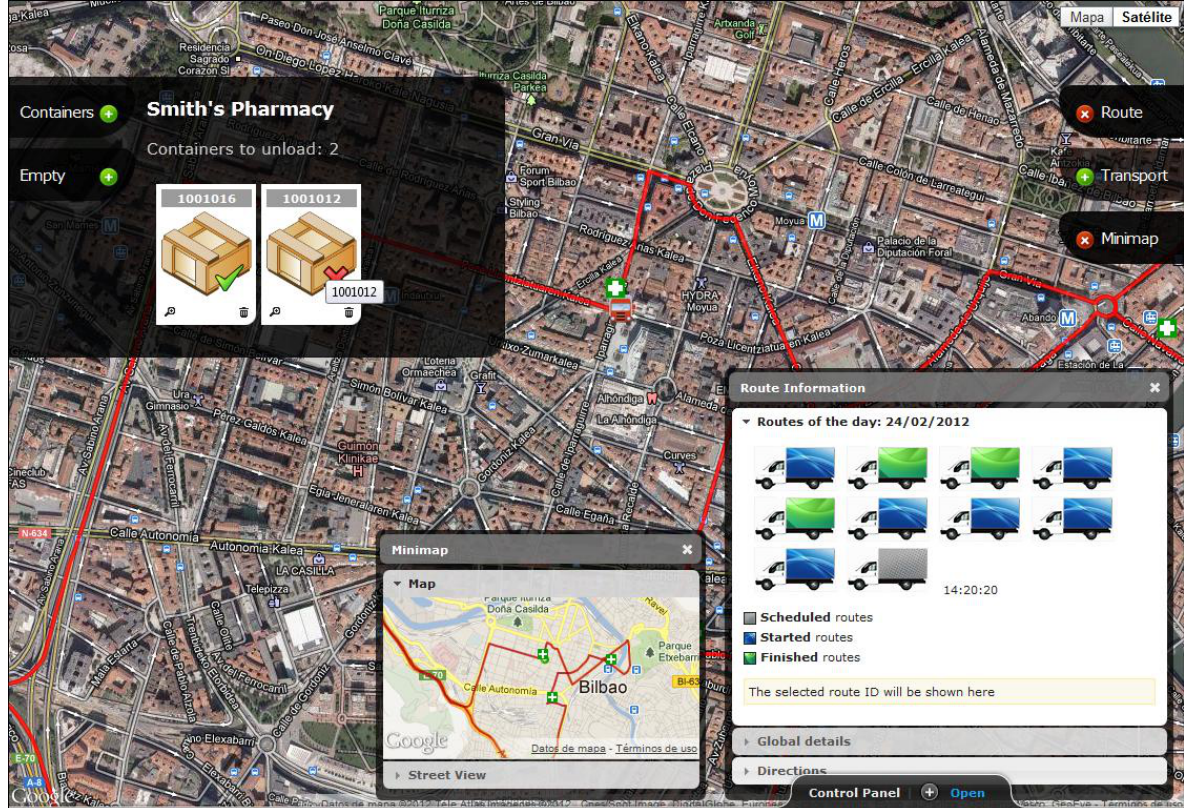
Figure 12. Web interface of the control software solution.